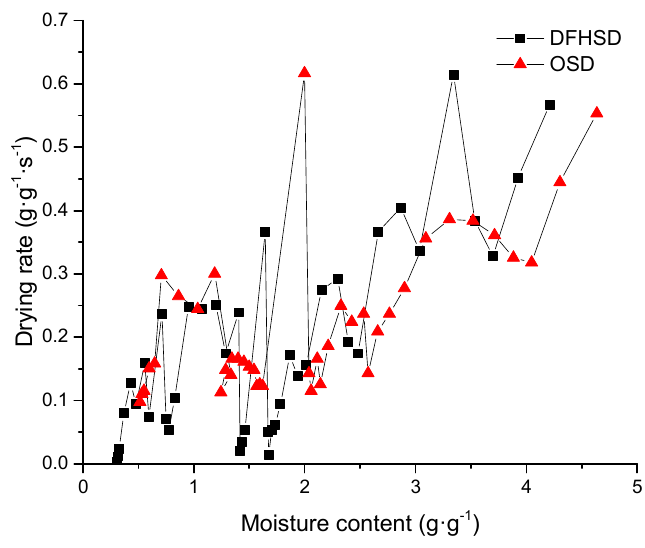
Figure 9. The change of drying rate for lemon slices’ drying.